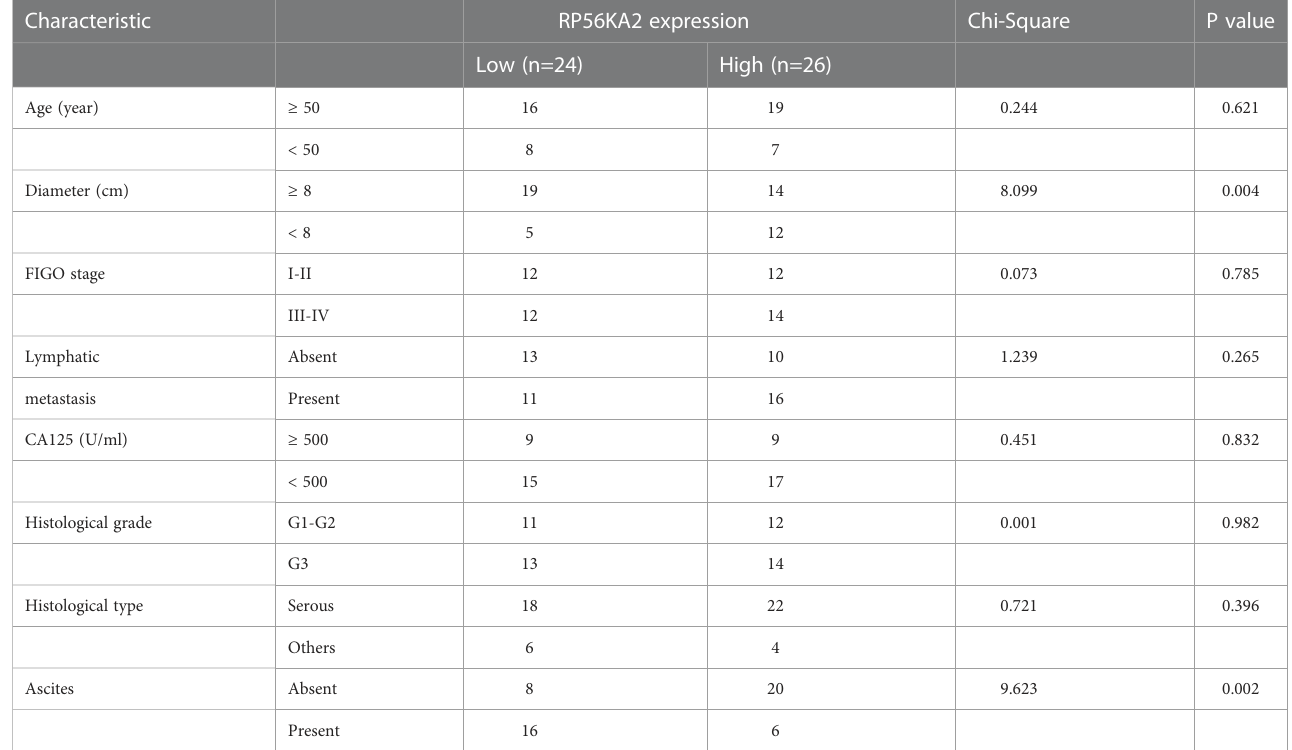
TABLE 1 Comparison of clinicopathological pro fi les of ovarian cancer patients between the low and high RPS6KA2 expression groups. Characteristic RP56KA2 expression